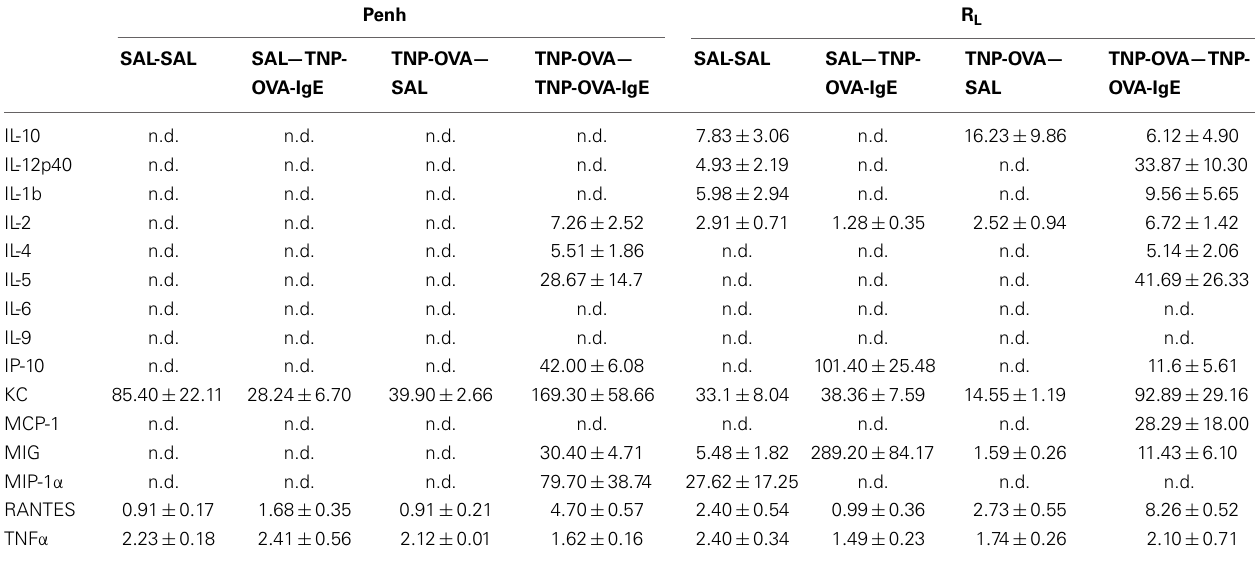
Table 6 | Chemokine and cytokine concentration in broncho-alveolar lavage fluid in the severe airway inflammation